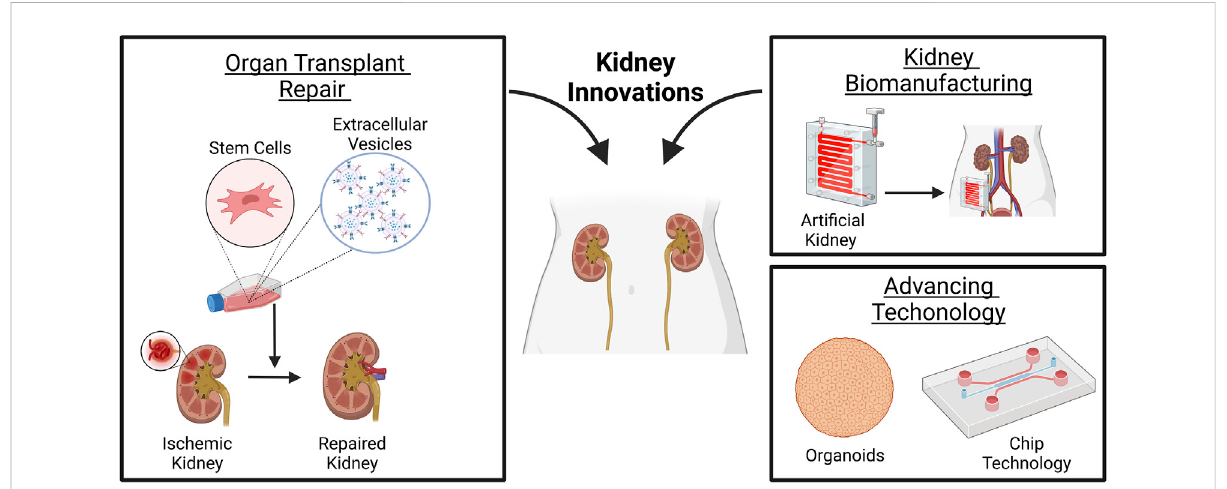
FIGURE 1 Innovations made in renal medicine. Stem cells or derived EVs may mitigate ischemic renal damage before or after transplantation. The design ofarti fi cialkidney devices, although limitedinfullymimickingkidneyfunction, i.e., secretion ofendocrineandimmunologic factors,reabsorption,or metabolism, may allow home dialysis and self-care renal replacement therapy for patients waiting for a transplant. Advancing technology in organoidsand chipsystemsmay serveas aplatformto study disease mechanismsand perform drug screeningstudies with highreproducibility for the design of patient-speci fi c therapies. Created with